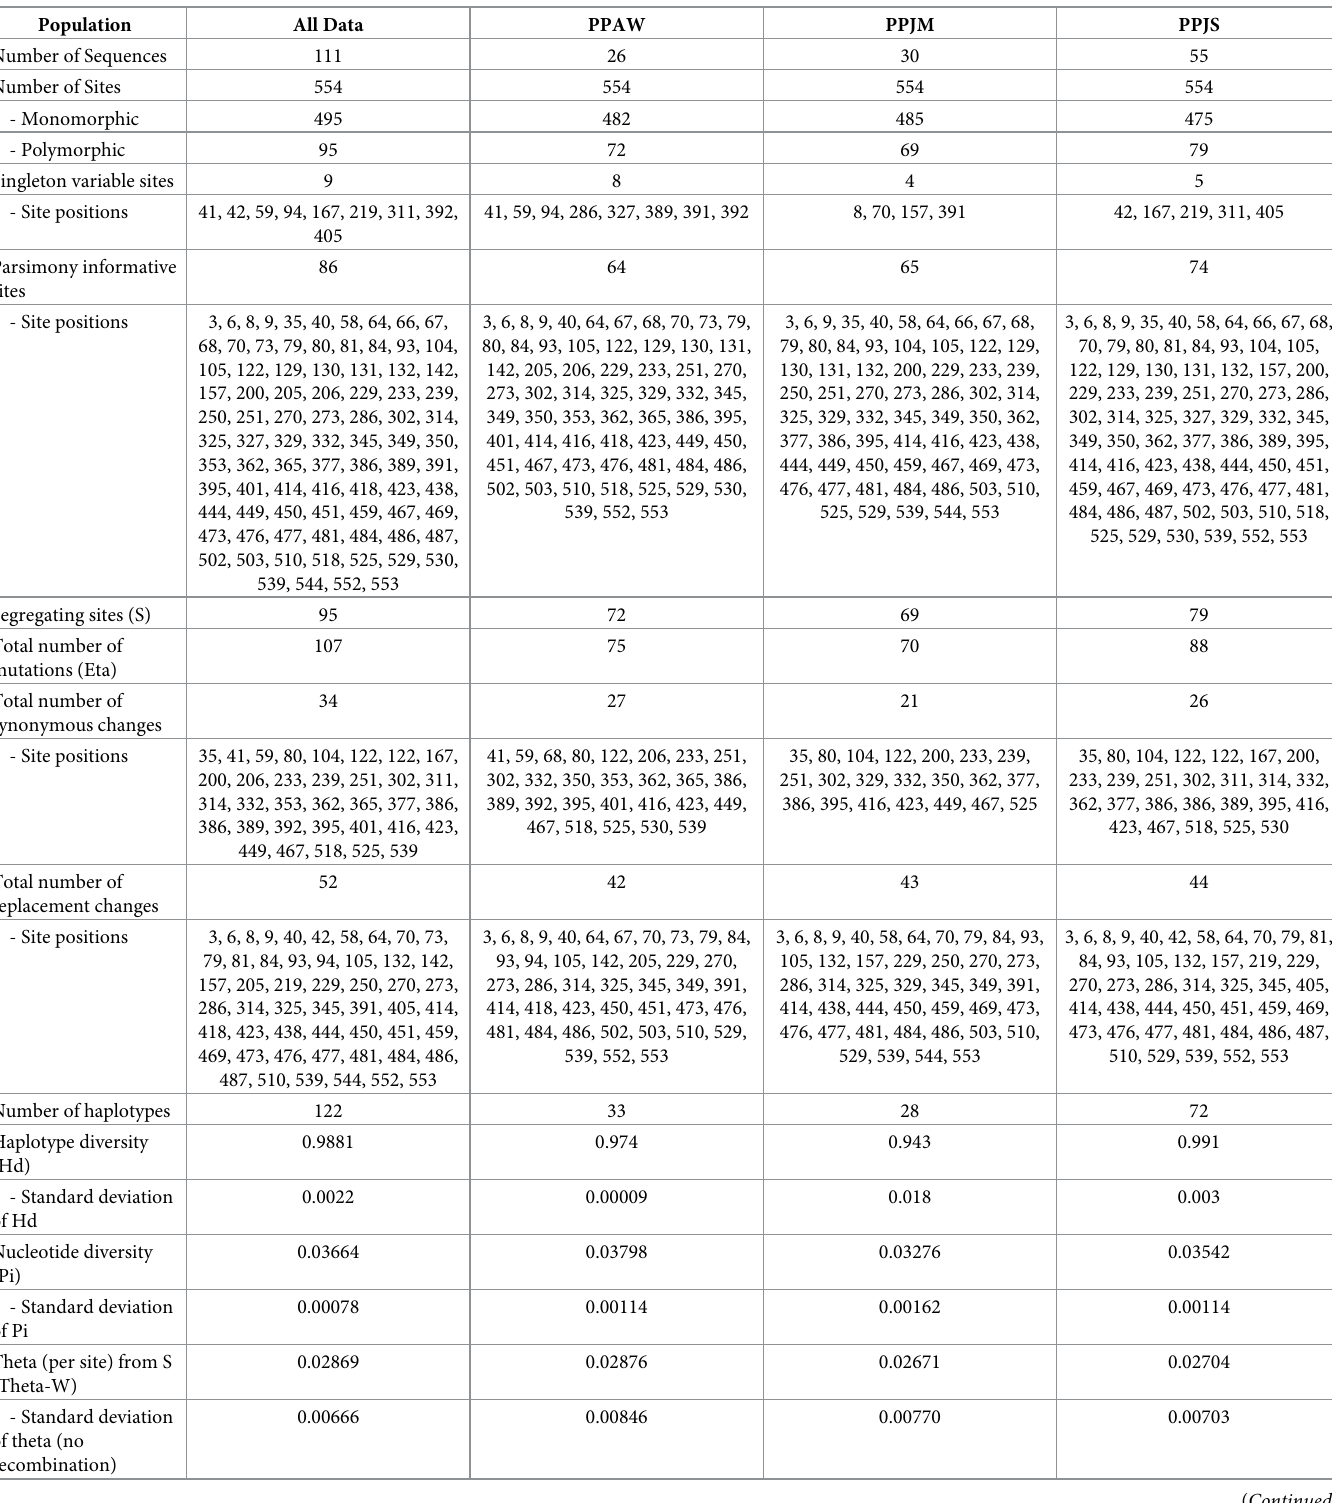
Table 8. PpSP28 population genetics analyses for P . papatasi